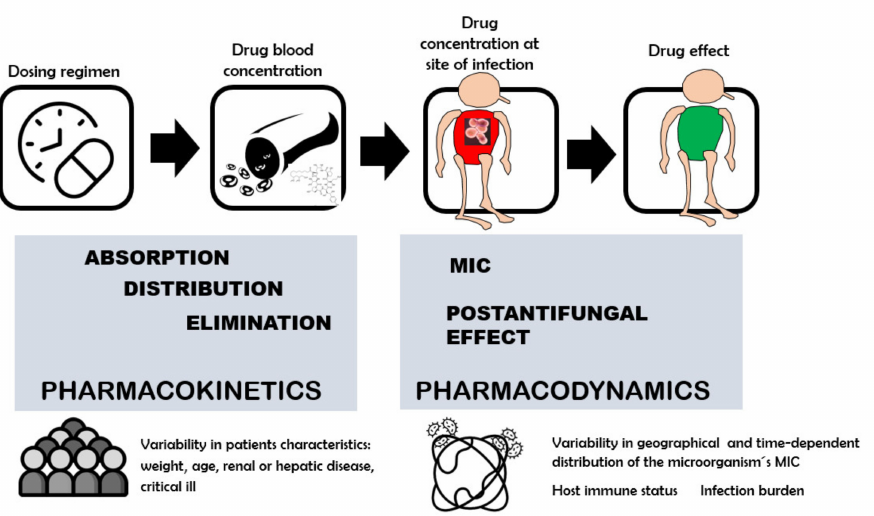
Figure 2. Dose–antifungal response relation. PK and PD properties of antifungal drugs and main sources of